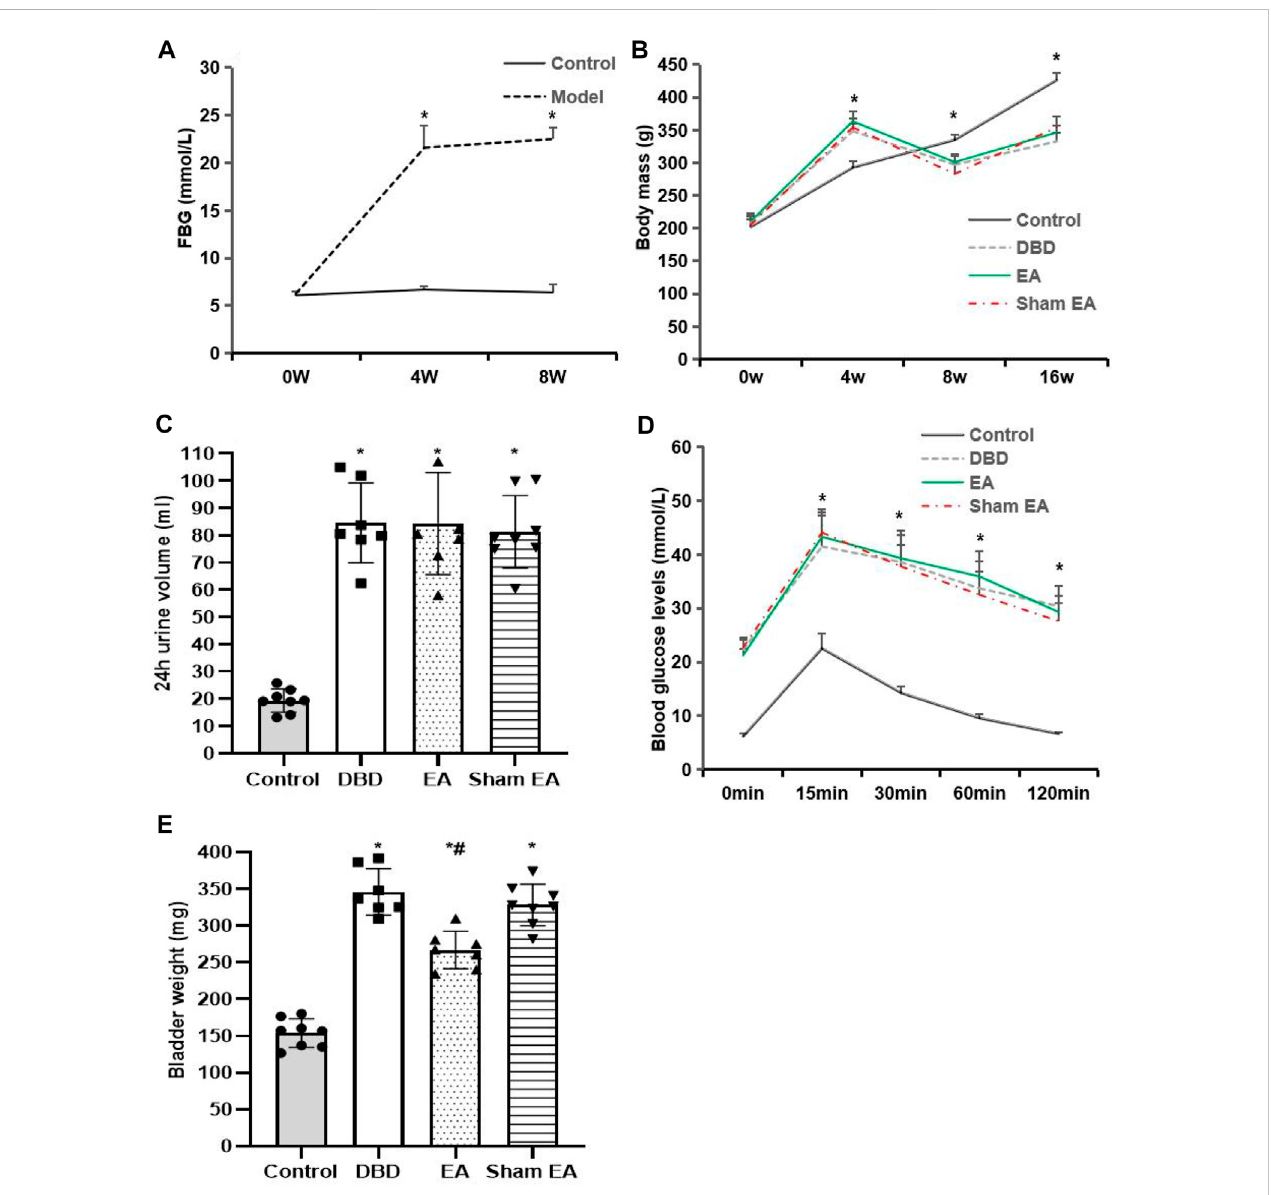
FIGURE 2 Generalcharacteristicsofeachgroup. (A) FBG:fastingbloodglucose; (B) Bodymass; (C) 24 hurinevolume; (D) IPGTT:intraperitonealglucosetolerance test; (E) Bladderweight.Control: n =8rats,DBD: n =7rats,EA: n =7rats,ShamEA: n =8rats.Resultsareexpressedasmean±standarderrorofthemean.* p < 0.01 versus the Control group, # p < 0.05 versus the Sham EAgroup (Student ’ s t-test was used to analyze thedata of theFBG, and one-way ANOVA to the rest of the